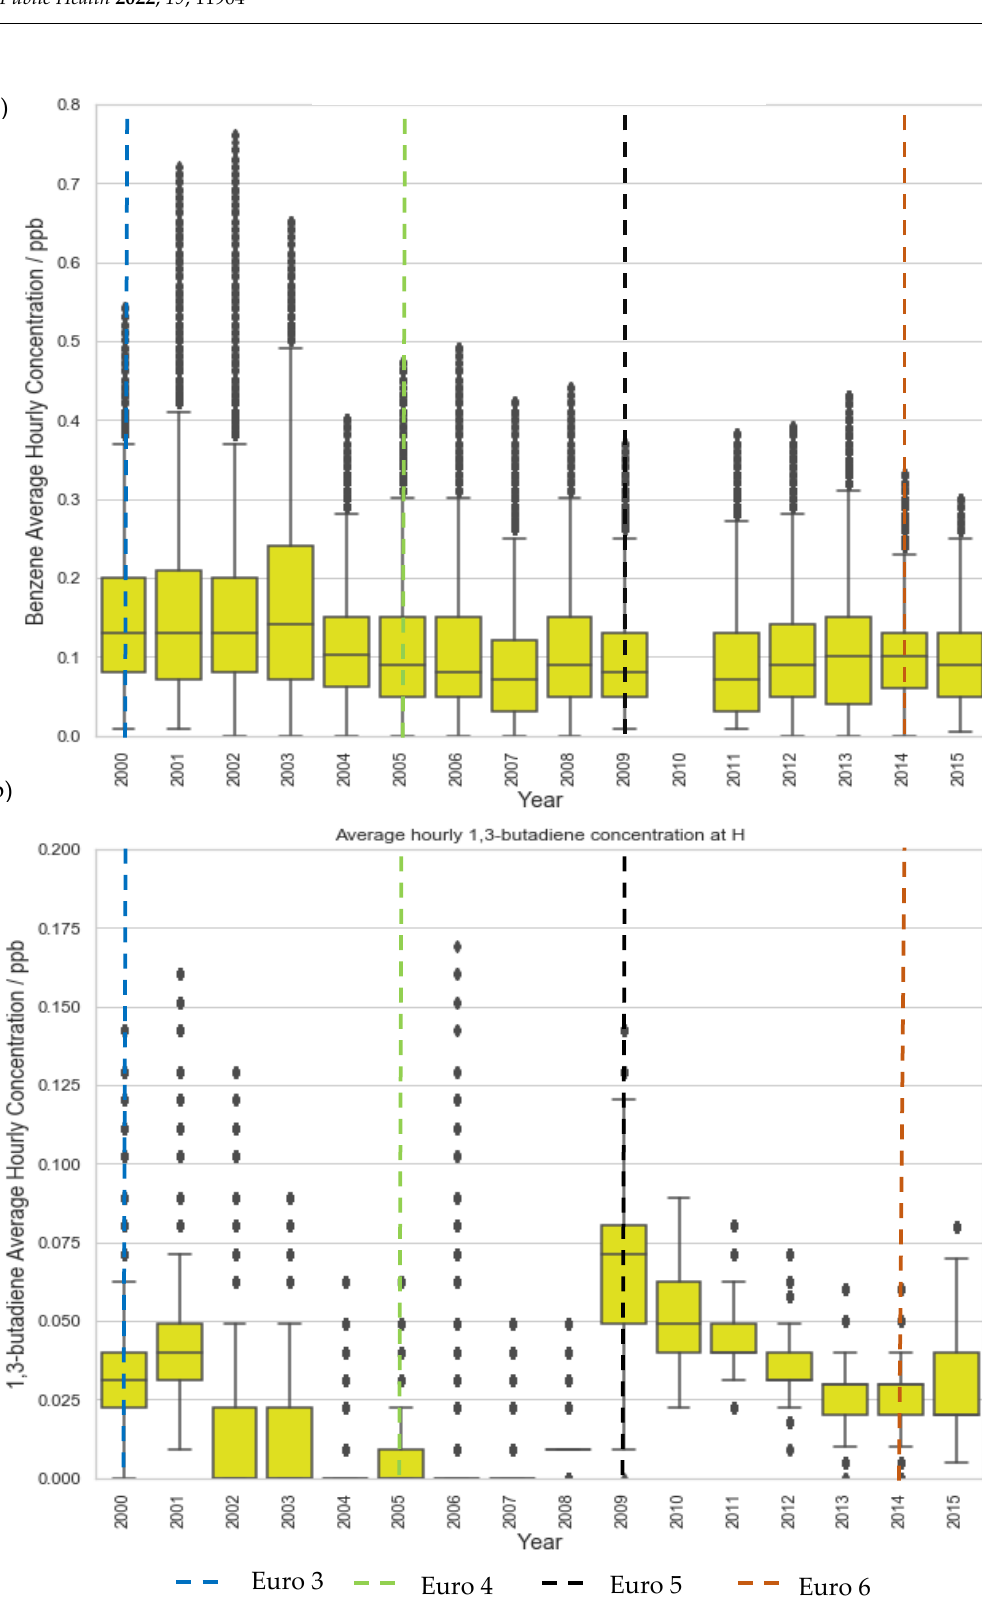
Figure 4. Trends in hourly-average pollutant concentration at the rural site H over the period 2000 – 2015 ( a ) benzene and ( b ) 1,3 butadiene. Error bars represent the 95% confidence level in pollutant concentration. Vertical lines represent implementation year of each relevant Euro control. Years with data coverage below 70% were omitted from analysis to avoid seasonal skewing (see Appendix A for data coverage representation).